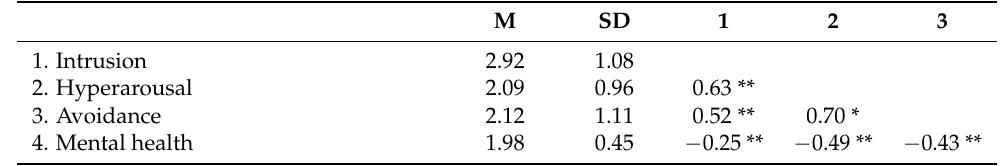
Table 5. Mean, standard deviation, and correlations among the study variables in Study 2.